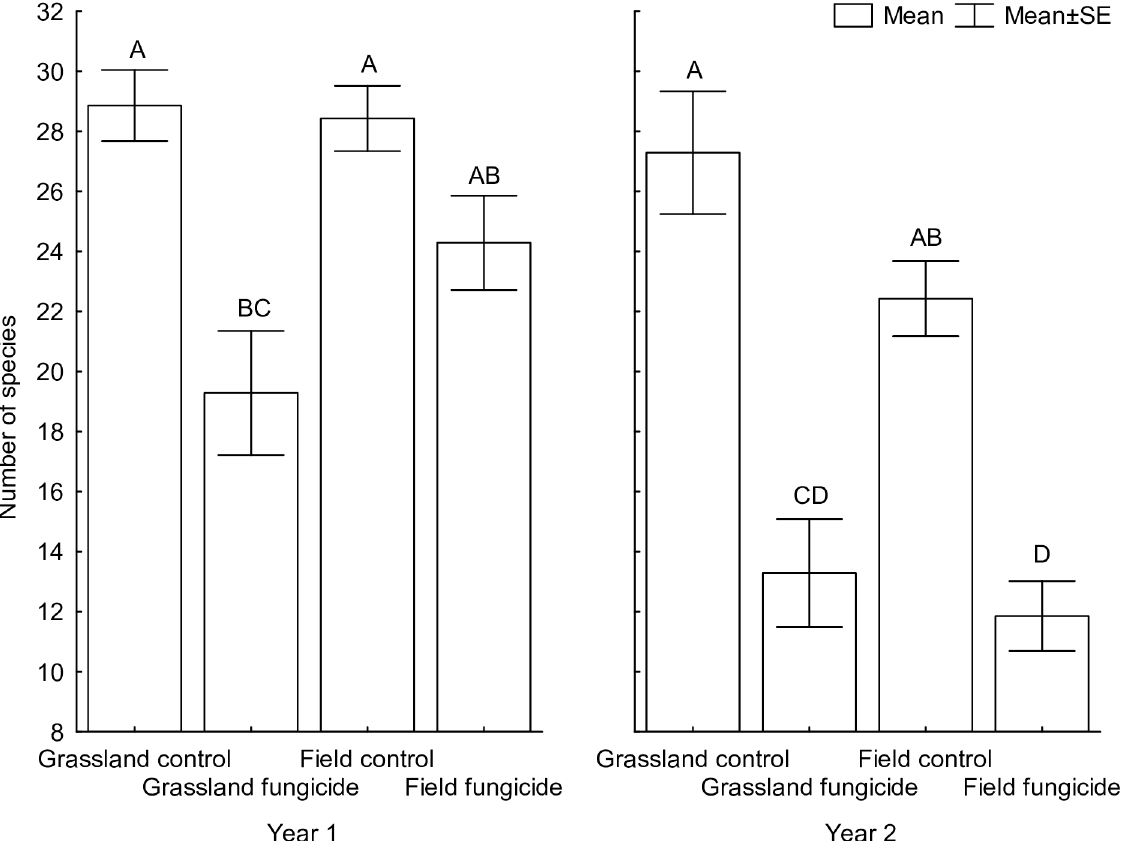
Fig 1. The effects of soil type, fungicide application and year on the number of species in the microcosms. Columns sharing the same letter are not significantly different (p > 0.05).